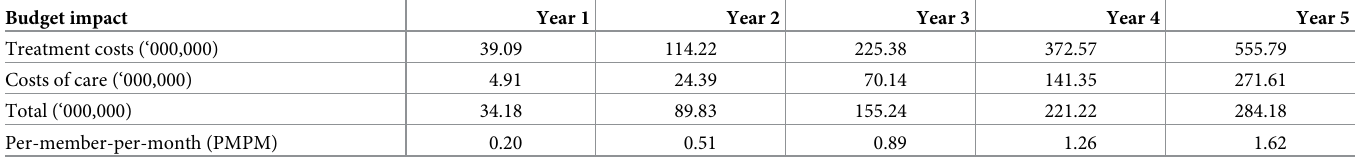
Table 3. Budget impact analysis of increasing uptake of renin-angiotensin system inhibitors (RAS) drugs to standard anti-hypertensive treatments for patient with hypertension and diabetes in Malaysia.